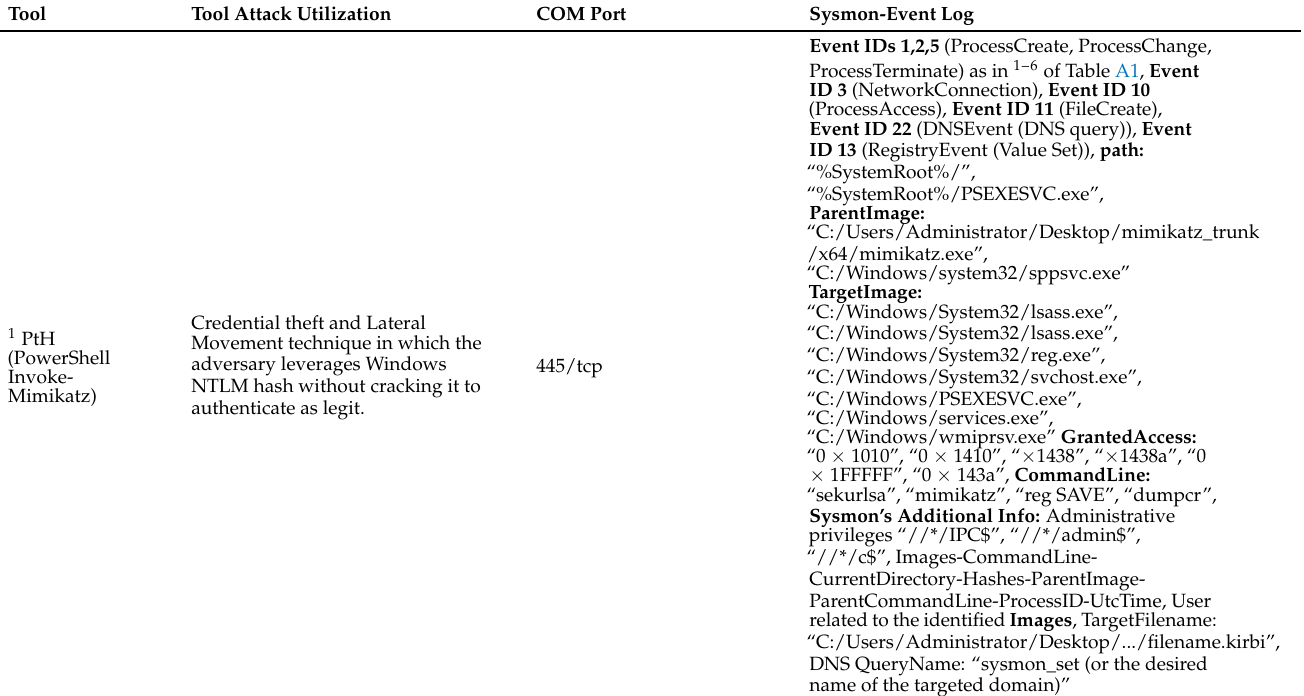
Table A2. Summary of the most important rule-based features included in Section 6.2. The